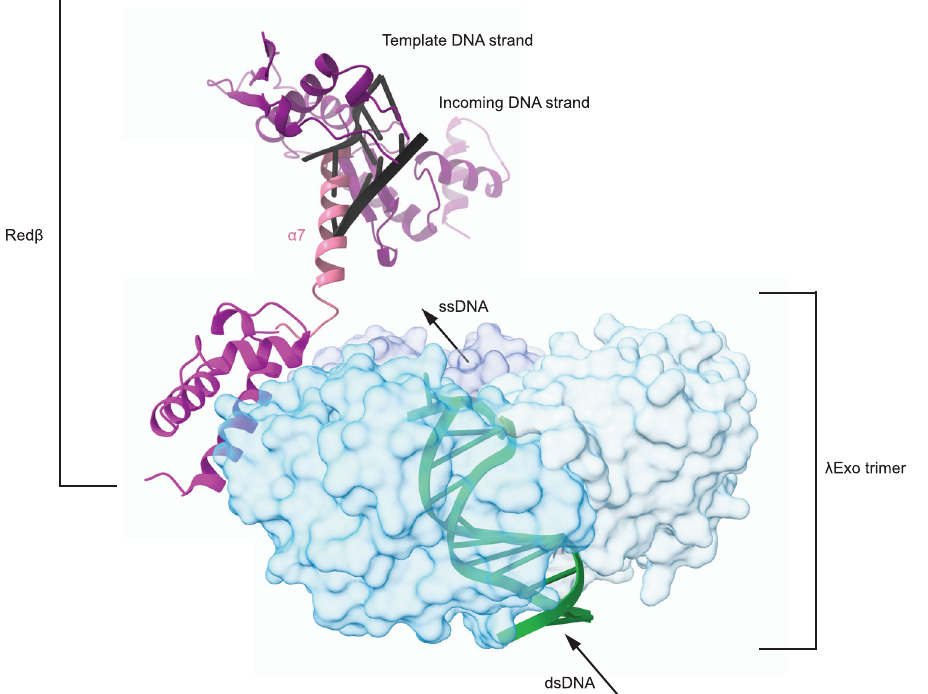
Fig. 7 | Superimposed molecular structures of Red β , λ Exo and DNA. This molecularscenewascreatedbypiecingfourstructurestogether.Theseincludethe structure of λ Exo bound to DNA 66 (4WUZ, three λ Exo monomers represented as surfacesindifferentshadesofblueandDNAingreen);thestructureof λ Exobound to the C-terminal domain of Red β 53 (6M9K, C-terminal domain of Red β shown in